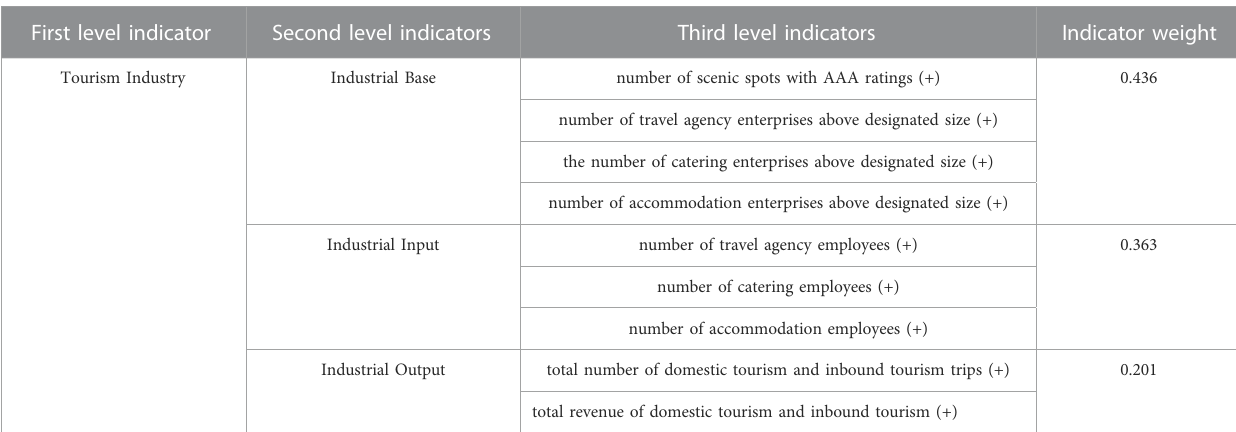
TABLE 1 Index evaluation system and weight for the tourism